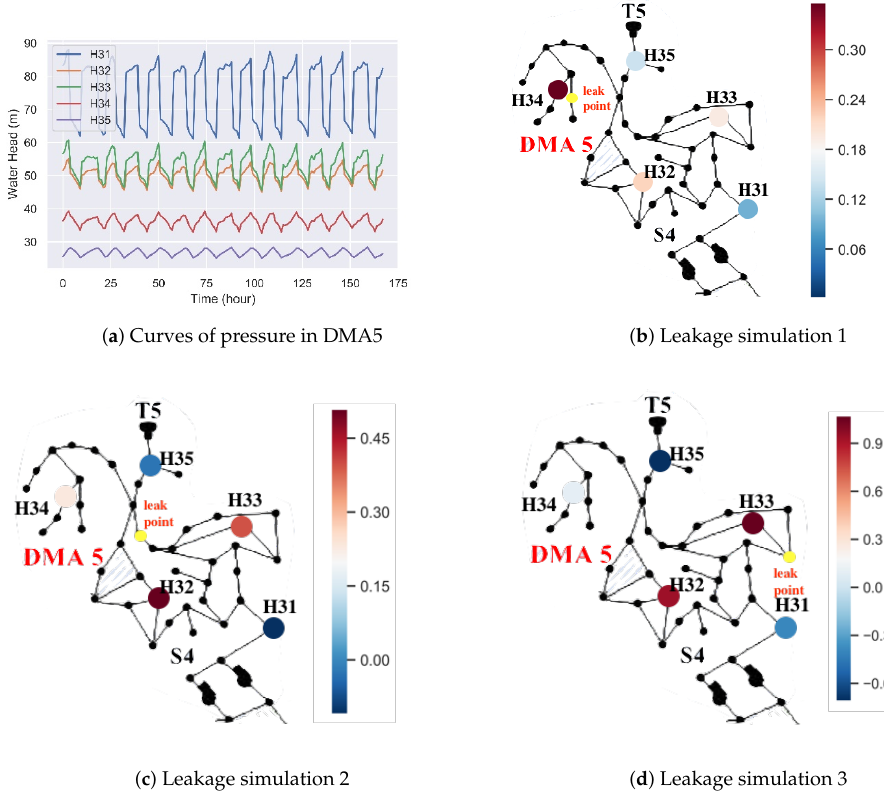
Figure 10. Weighted average coefficients of pressure sensors under different location of